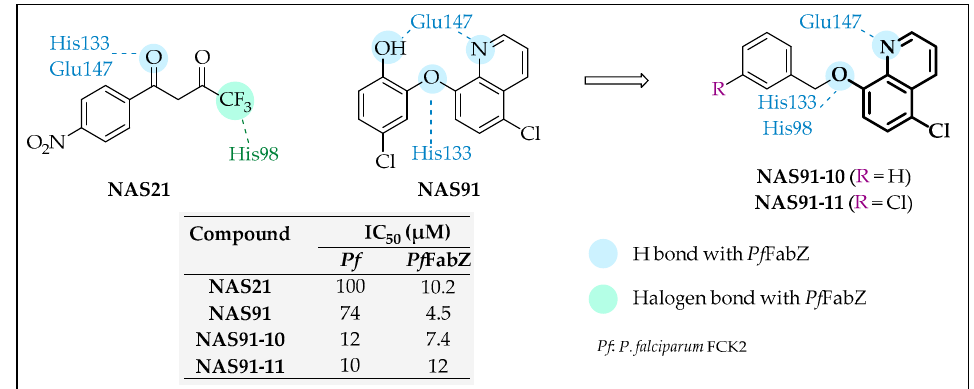
Figure 23. Structure, representation of main interactions with Pf FabZ and in vitro activities of NAS compounds [111,113].